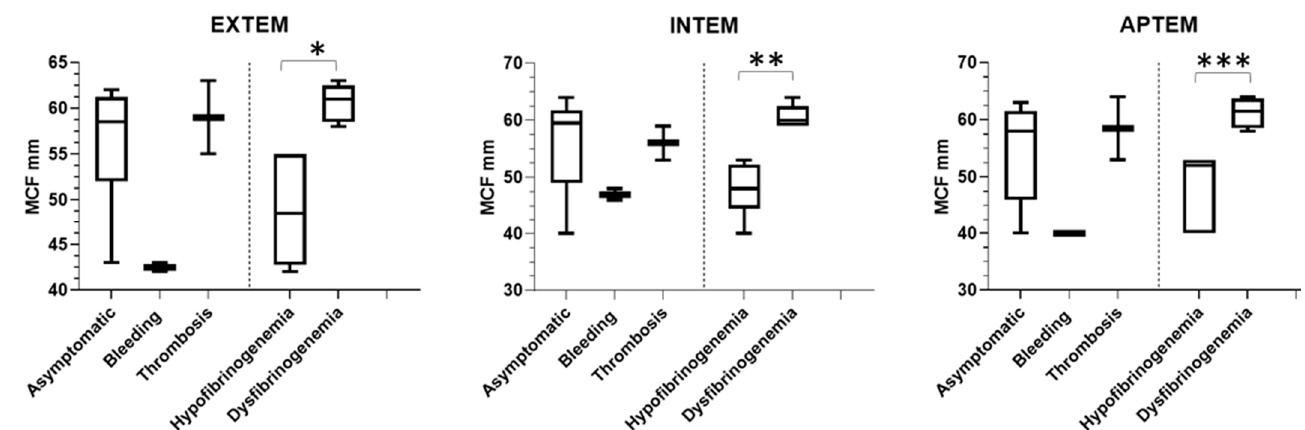
Figure 7. ROTEM profiles according to clinical and laboratory phenotypes. ( A ). FIBTEM CT and MCF are shown for 110 patients as follows: asymptomatic n = 7; bleeding n = 2, thrombosis n = 2; dysfibrinogenemia n = 6 and dysfibrinogenemia n = 5. * CT was markedly prolonged in hypo- in comparison with dysfibrinogenemia ( p = 0.0303). ** Fibrin polymerization capacity (clot firmness) in FIBTEM was decreased (MCF ≤ 6 mm) in hypofibrinogenemia as compared with dysfibrinogenemia ( p = 0.0022). ( B ). EXTEM, INTEM, and APTEM MCF are shown for 11 patients as follows: asymptomatic n = 7; bleeding n = 2, thrombosis n = 2; dysfibrinogenemia n = 6; and dysfibrinogenemia n = 5 MCF was markedly decreased in hypo- in comparison with dysfibrinogenemia in EXTEM (* p = 0.003), INTEM (** p = 0.004), and APTEM (*** p = 0.007).